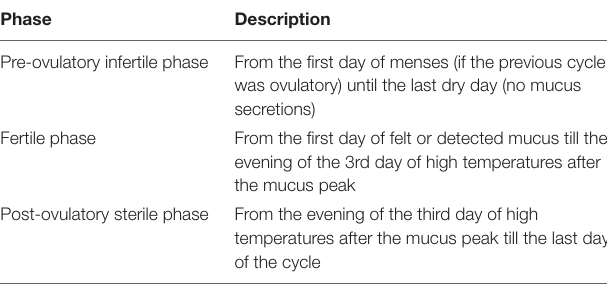
Table 2 | Menstrual phases according to the rule of the C.A.Me.N. symptothermal method.